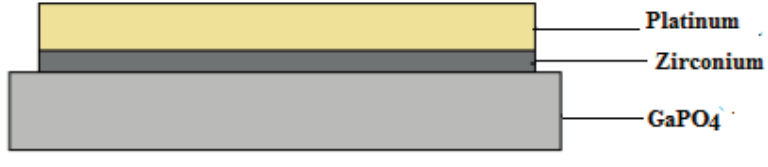
Figure 2. Top view illustration of the substrate.